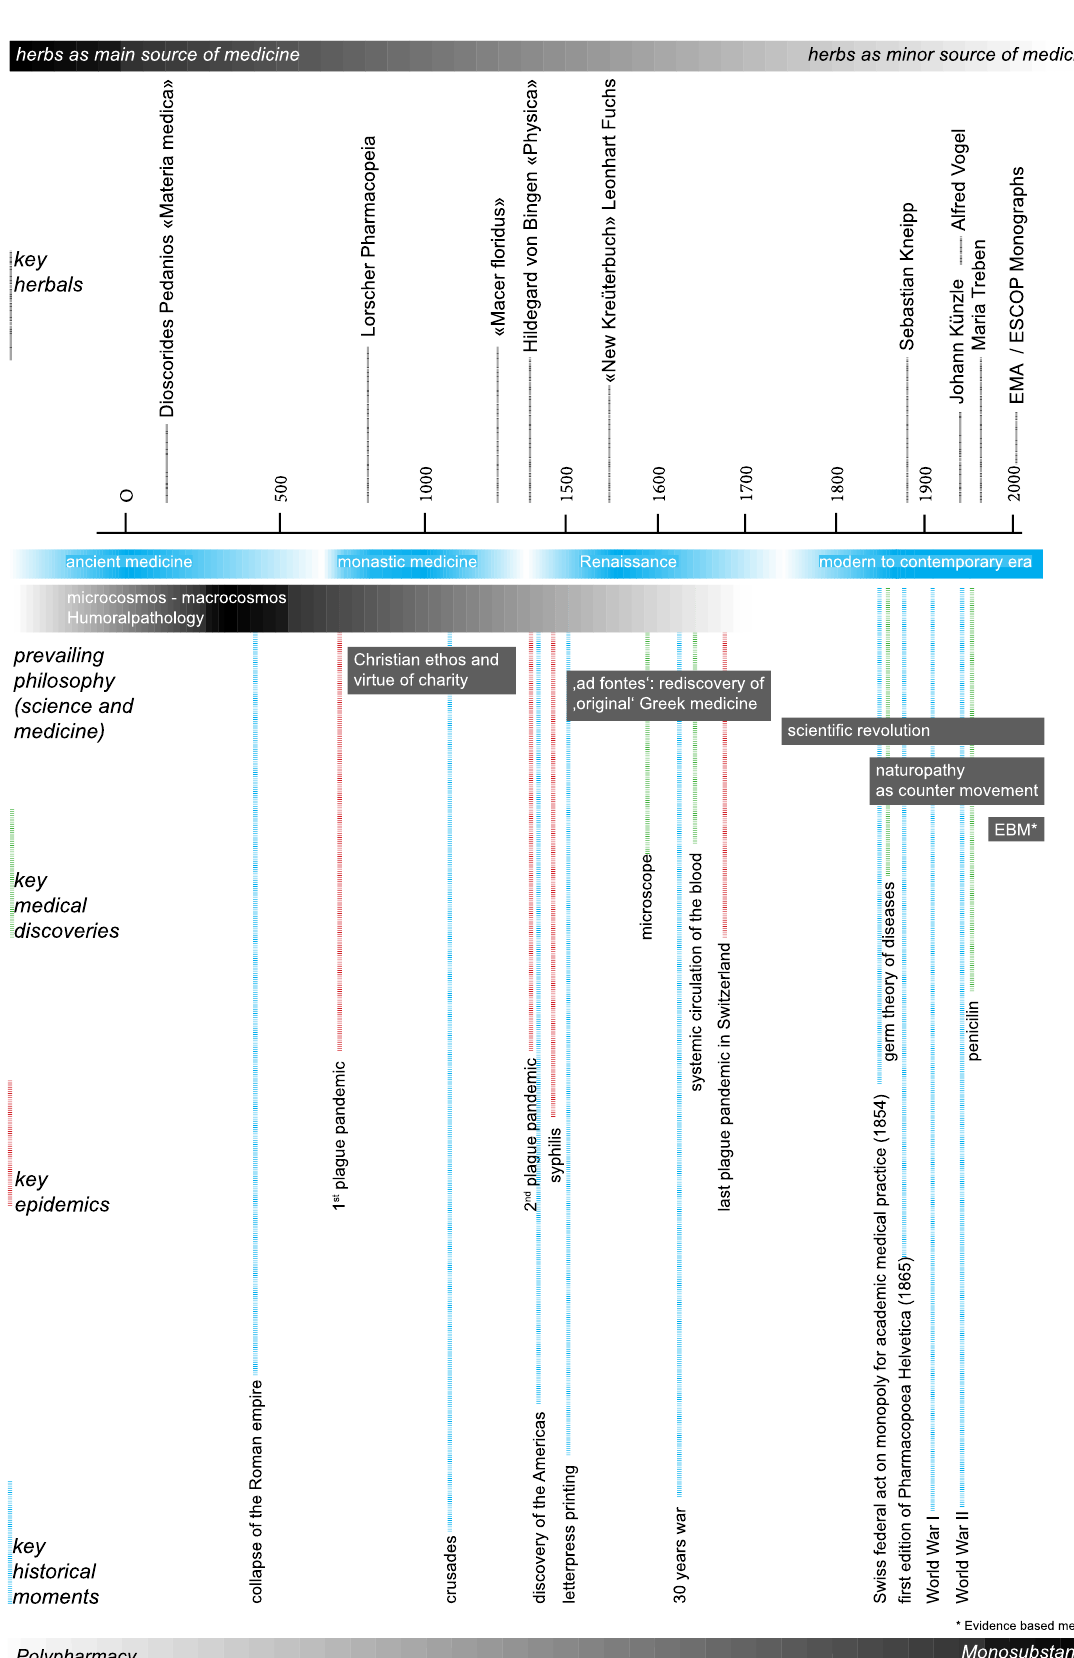
Figure 1. Synchronoptic view of key drivers influencing medicinal plant use.